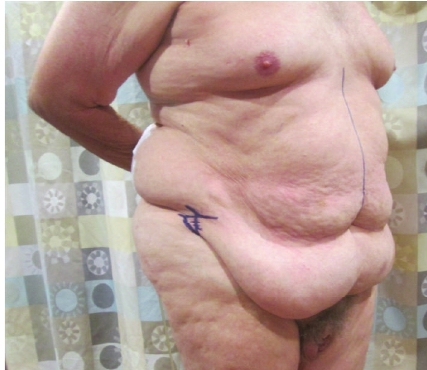
Figure 1: Preoperative photograph of patient, taken during inferior abdominal incision planning and marking.